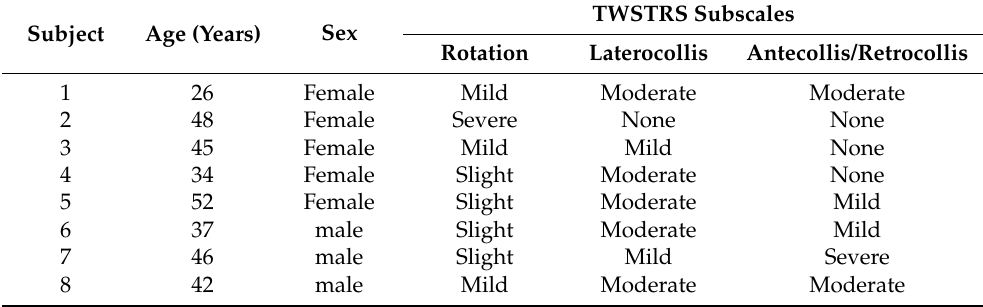
Table 1. Characteristics of